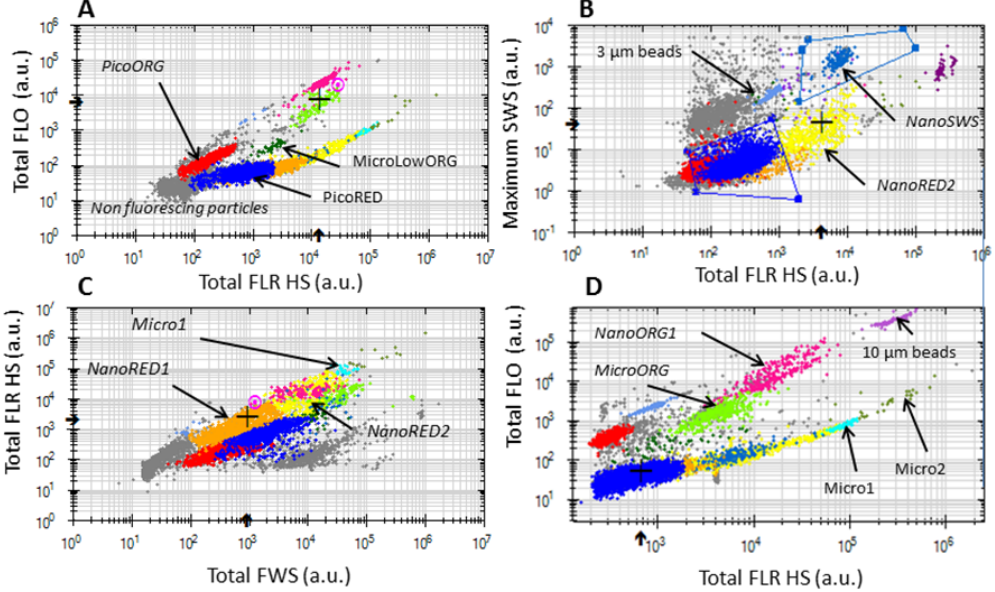
Figure 3. (a) TFLO vs. TFLR (a.u.) cytogram with an FLR trigger level at 10mV showing the PicoORG, PicoRED and MicroLowORG clusters. (b) Maximum SWS (a.u.) vs. TFLR (a.u.) cytogram with an FLR trigger level at 10mV showing the NanoSWS and NanoRED2 clusters and 3µm beads. (c) TFLR (a.u.) vs. TFWS (a.u.) cytogram with an FLR trigger level at 10mV showing the NanoRED1, NanoRED2 and Micro1 clusters. (d) TFLO vs. TLFR (a.u.) cytogram with an FLR trigger level of 25mV showing the NanoORG1, MicroORG, Micro1 and Micro2 clusters and 10µm beads. Cluster colours are consistent across different panels. Table 1. Minimal, maximal, average and standard deviation of abundance (cellscm − 3 ) for each defined phytoplankton cluster followed by the size-estimated (µm) average ± standard deviation values. Cluster’s name